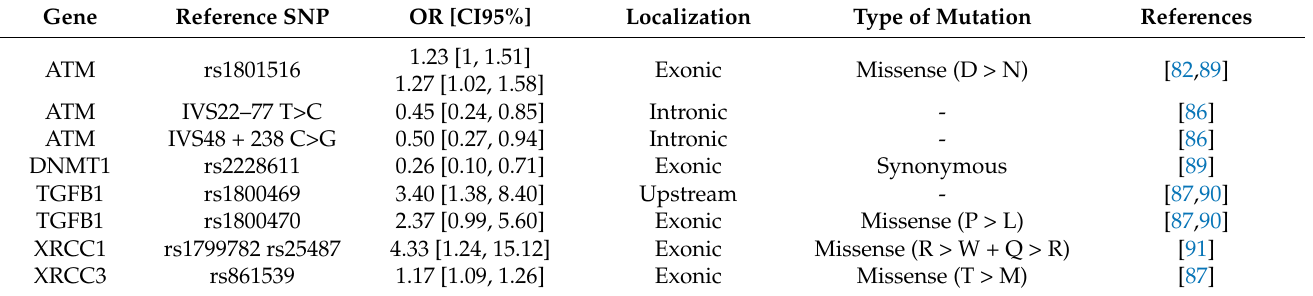
Table 2. Single nucleotide polymorphisms are linked with skin radiation-induced